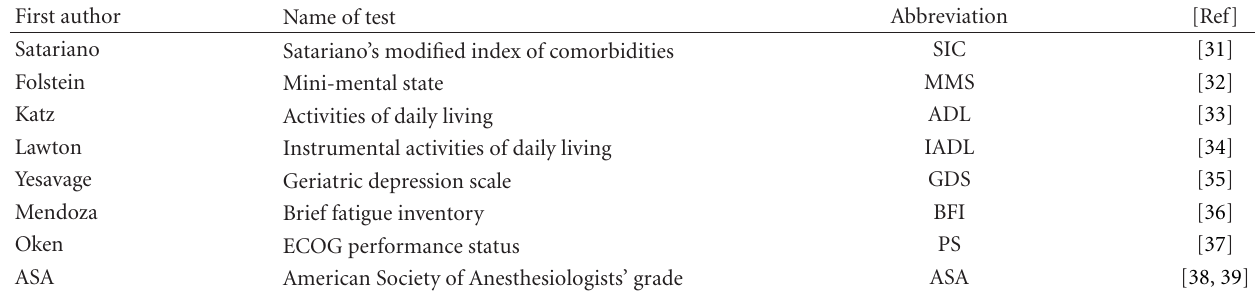
Table 1: Preoperative assessment of cancer in the elderly (PACE): a comprehensive assessment of underlying characteristics of elderly cancer patients prior to elective surgery.